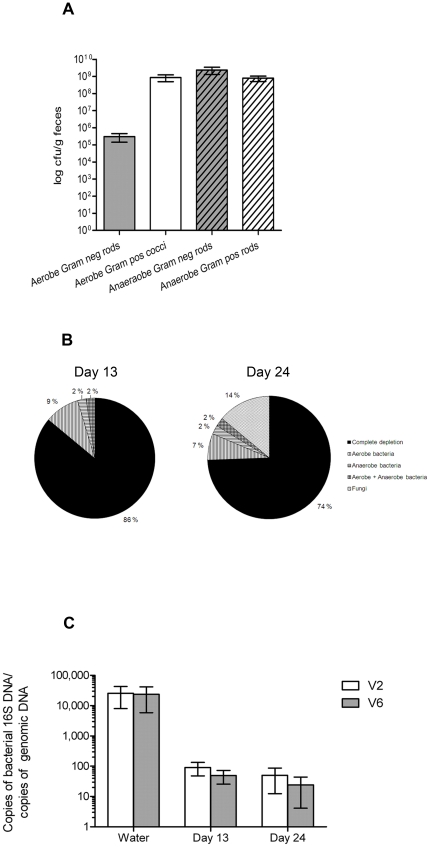
Protocol for administering antibiotics by gavage effectively reduces intestinal bacterial contents.(A) Enumeration of cultivable fecal bacteria (mean ± SEM) in untreated mice. (B) Efficacy of successful depletion (<1 cfu/mg feces) of cultivable gut microbiota and distribution of aerobe, anaerobe, and fungal overgrowth (def.: ≥1 cfu/mg feces) after 13 and 24 days of treatment with vancomycinm (V), neomycin (N), metronidazol (M), and amphotericin-B (Amf-B) every 12 hours by gavage with ampicillin ad libitum in drinking water (A), n = 43. (C) Bacterial 16S DNA load (mean ± SD) in fecal pellets. 16S DNA determined by quantitative PCR for the V2 and V6 regions and normalized to total mouse genomic DNA in the same pellets of mice treated 13 and 24 days with VNMAmf-B +A compared with water controls, n = 7 for water controls, 40 for 13 days, and 35 for 24 days.